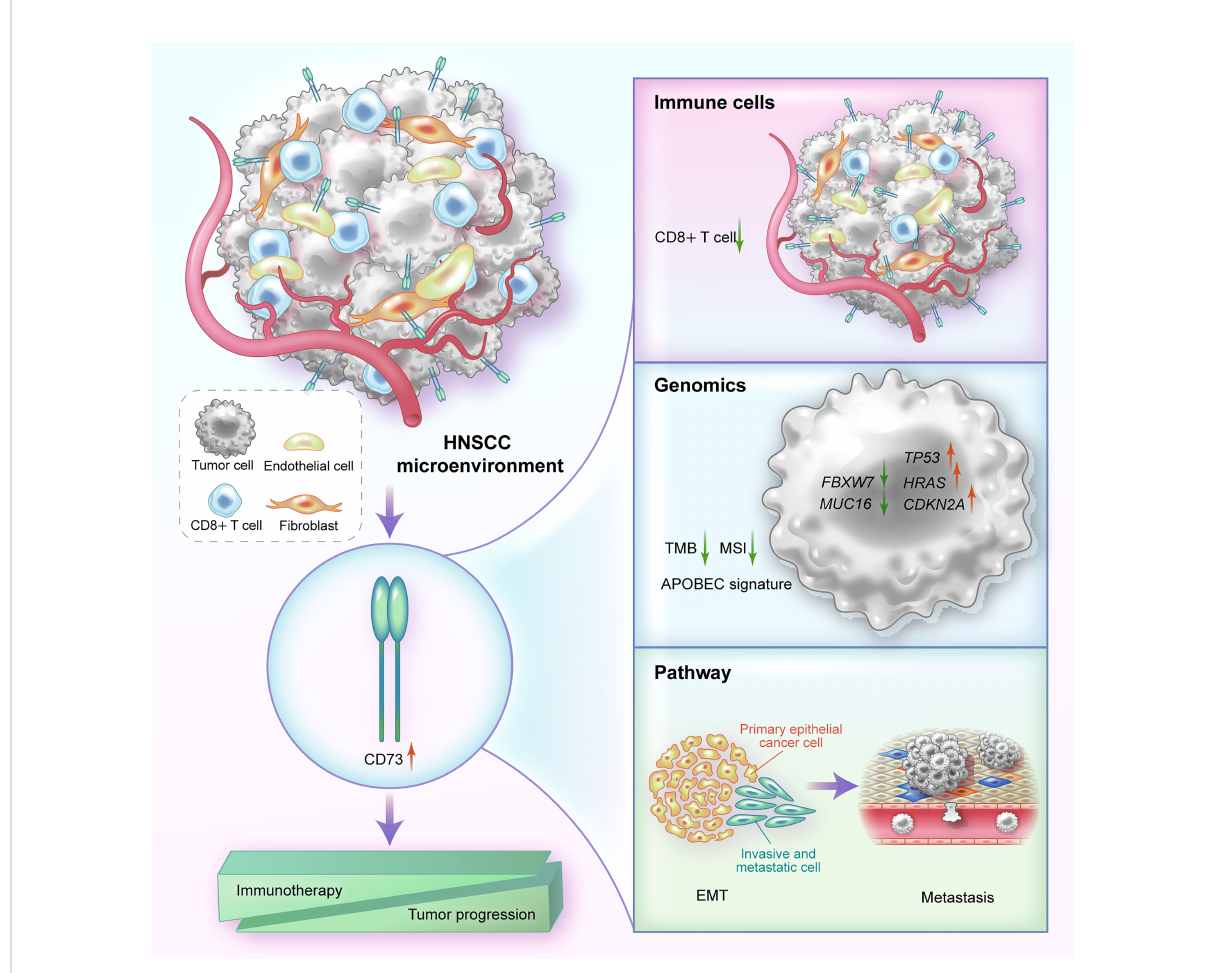
FIGURE 5 A graphical illustration of mechanism summary of this study. In HNSCC, CD73 is mainly highly expressed on fi broblasts, endothelial cells and tumor cells. High expression of CD73 can affect immune resistance and tumor progression by reducing the proportion of immune cells such as CD8 + T cells, altering genomic biomarkers, and regulating EMT-related